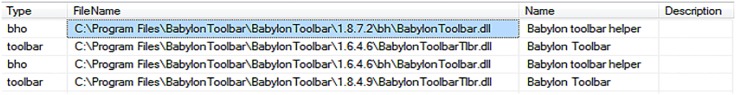
Example of coreferent addon records with different software version numbers.